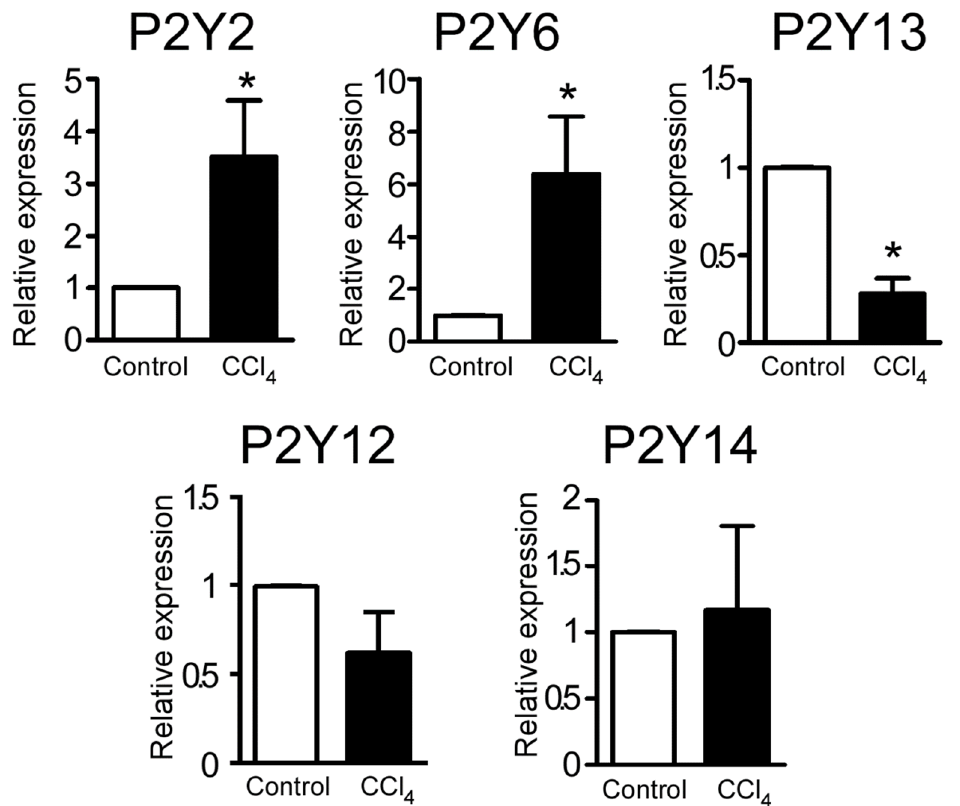
Figure 2. Effect of CCl 4 -administration on the expression level of P2YRs in mouse liver homogenates. Relative expression level of P2yr2, P2yr6, P2yr12, P2yr13 and P2yr14 from vehicle- and CCl 4 -injected mice analyzed by qPCR; data are expressed as fold of control group. * p < 0.05, Student’s t- test. n = 6 for P2yr2 and P2yr6 ; and 5 for P2yr12, P2yr13 and P2yr14 .